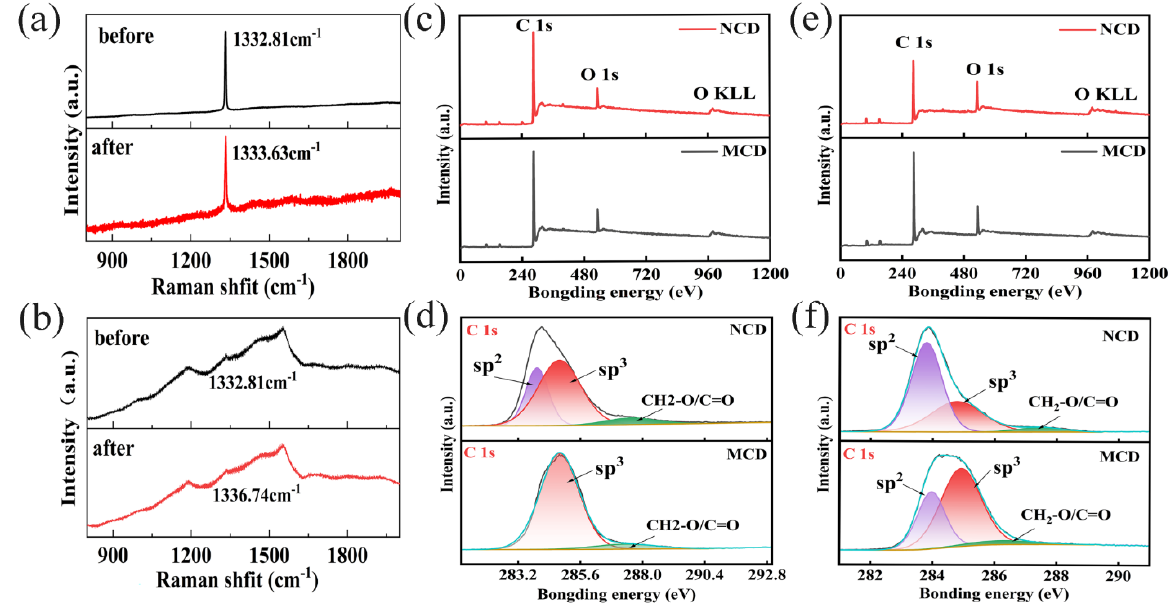
Figure 6. ( a ) The Raman spectrum of MCD coating before and afetr test; ( b ) The Raman spectrum of NCD coating before and afetr test; ( c , d ) The XPS spectra of the surface of the worn track before test; ( e , f ) The XPS spectra of the surface of the worn track after test under dry